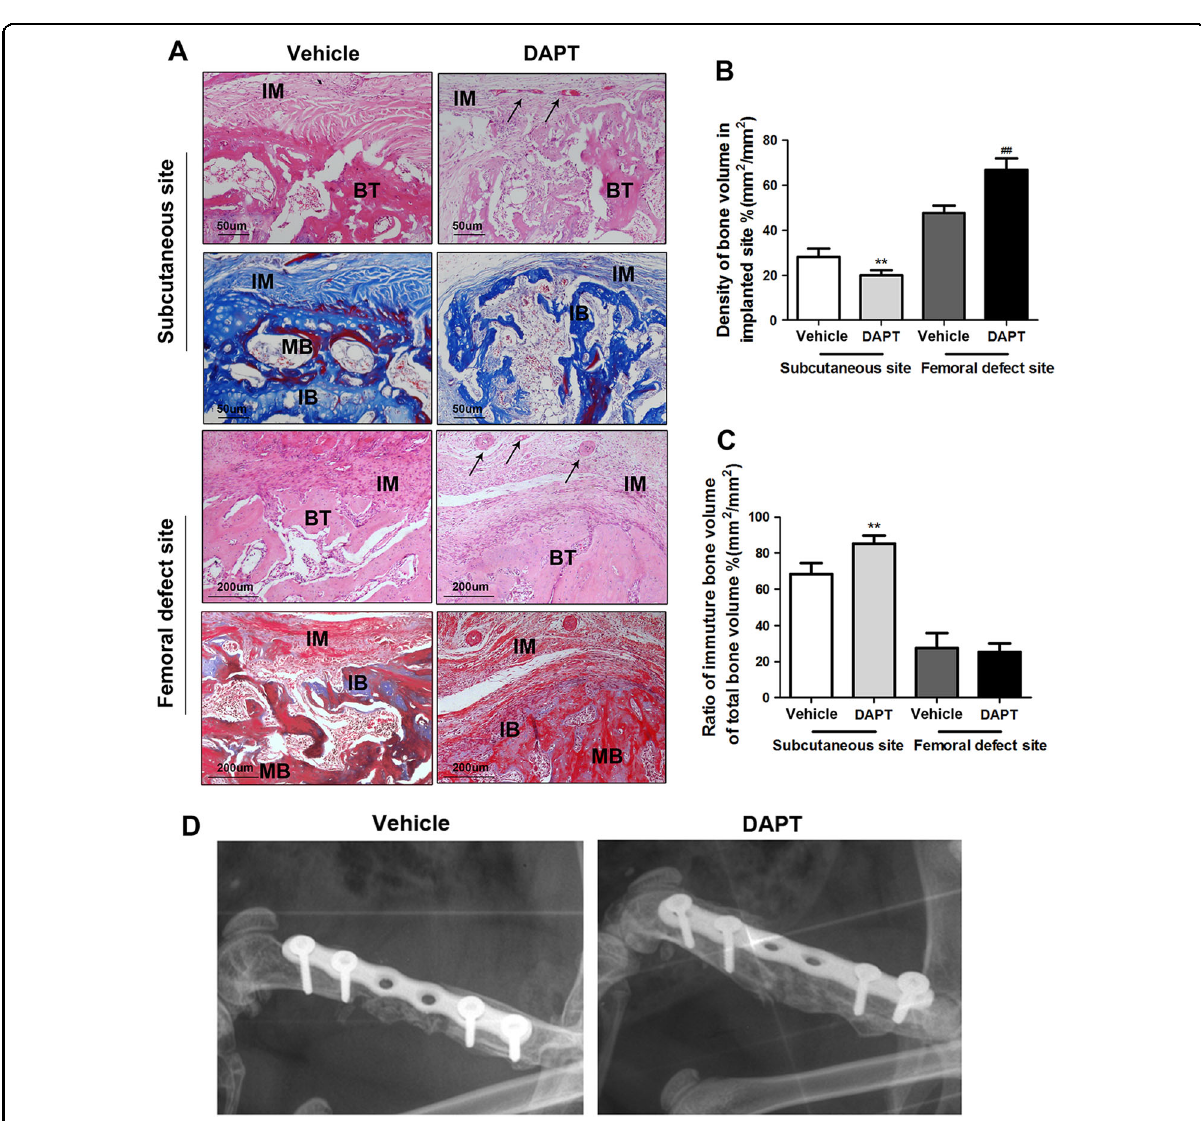
Fig. 5 DAPT-modi fi ed induced membrane promotes bone formation in the femoral defect site but induced graft resorption in subcutaneous site. a Representative image of H&E staining and Masson ’ s staining in the subcutaneous site and femoral defect site after 12 weeks of autogenous bone grafting (scale bar: 50 μ m/200 μ m, black arrows indicate microvessels, IM represents induced membrane, BT represents bone tissue, MB represents mature bone, IM represents immature bone). b Quantitative results of the bone mass density in the implanted site. c Quantitative results of the ratio of immature bone volume to the total bone volume. The data in the fi gures represent averages ± S.D. The data in the fi gures represent averages ± S.D. Signi fi cant differences between the different groups are indicated as ** P < 0.01, compared with saline-treated induced membrane in the subcutaneous site; ## P < 0.01, compared with saline-treated induced membrane in the femoral defect site. d X-ray image of explanted femurs 12 weeks after the second surgical step. Bone graft harvested from caudal vertebrae was used to fi ll the cavity delineated by different induced membranes. Grafts in vehicle-treated rats showed no bridging callus formation between the fracture end and graft (white arrow). Successful bone union was achieved in the grafted femurs in DAPT-modi fi ed induced membrane. For each group, n =